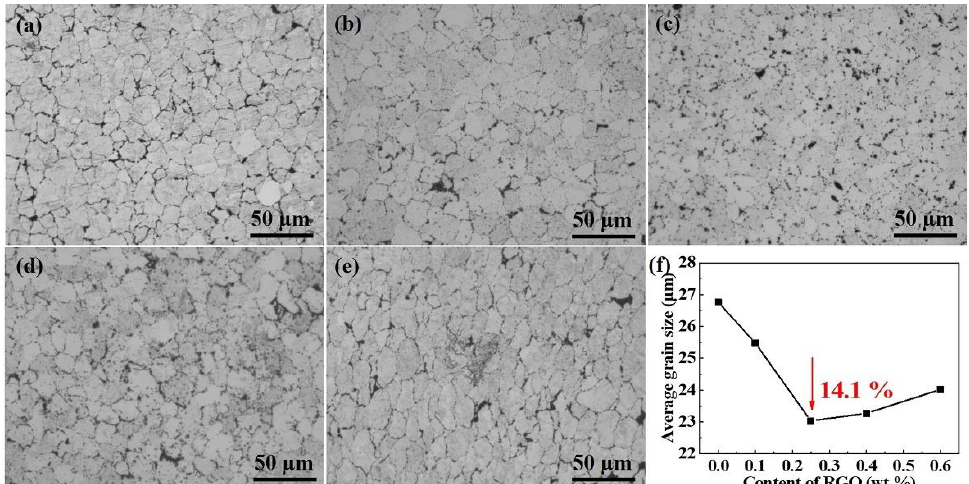
Figure 7. Microstructure of ( a ) ZK61 alloy and its composites containing ( b ) 0.1 wt.%, ( c ) 0.25 wt.%, ( d ) 0.4 wt.% and ( e ) 0.6 wt.% RGO. ( f ) The average grain size of RGO-reinforced magnesium matrix composites with different RGO content.